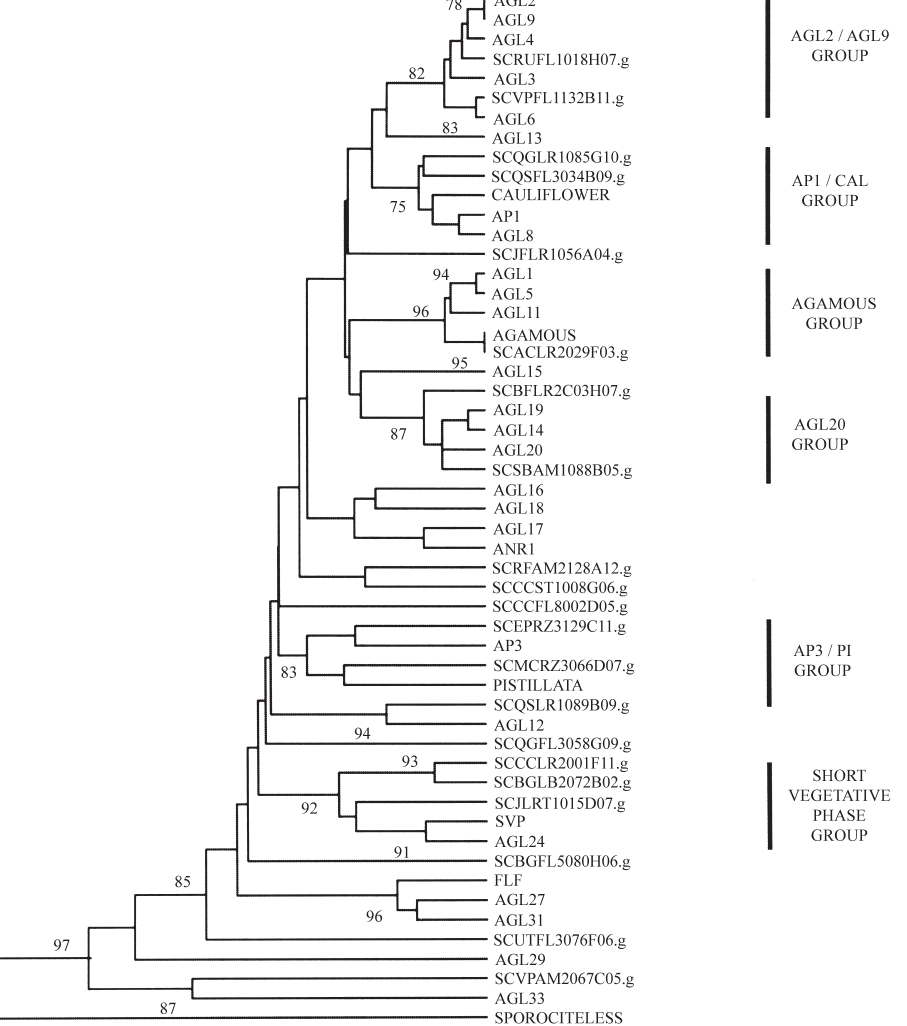
Figure 1 - Phylogenetic relationships of the sugarcane MADS-box transcription factors and their putative homologues from Arabidopsis . The most par- simonious consensus tree resulted from the branch-and-bound algorithm. Trees with similar topology were also obtained using a distance matrix and neighbor-joining. Only Bootstrap values (1000 replicates) higher than 75% are shown. For reference numbers and references to the gene sequences used, see